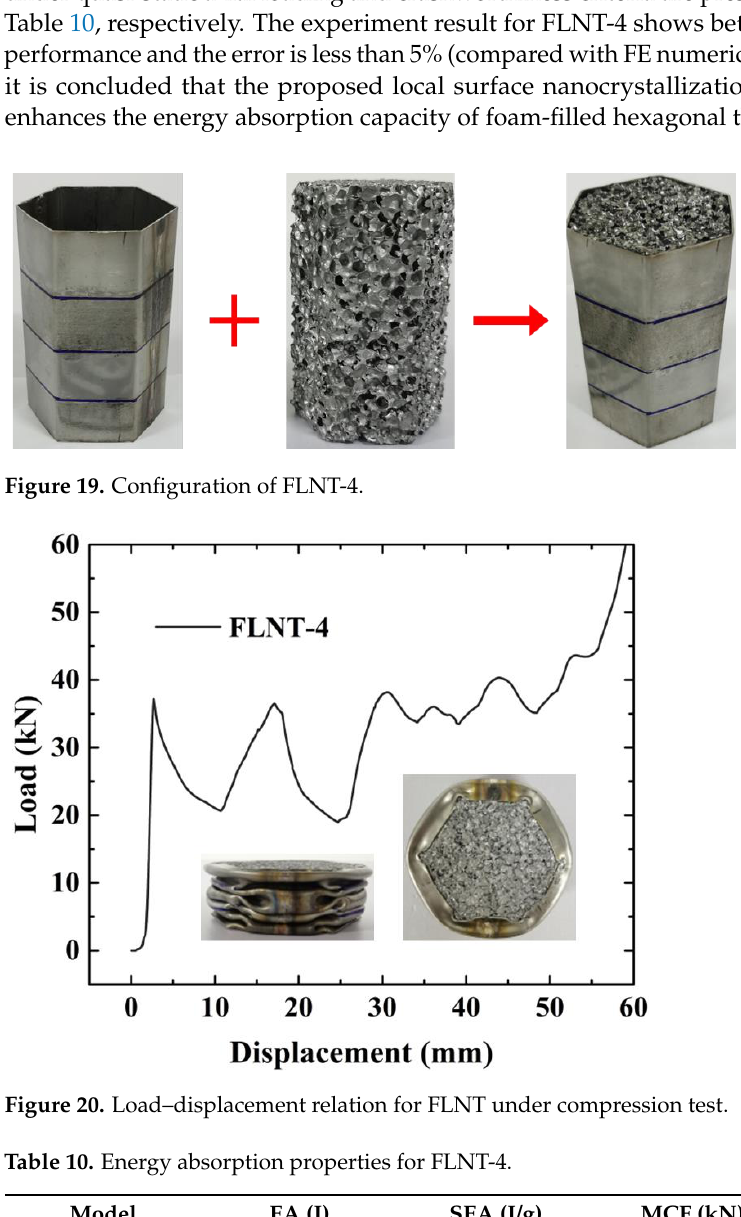
Figure 18. Effect of stripe number on energy absorption and peak crushing force.